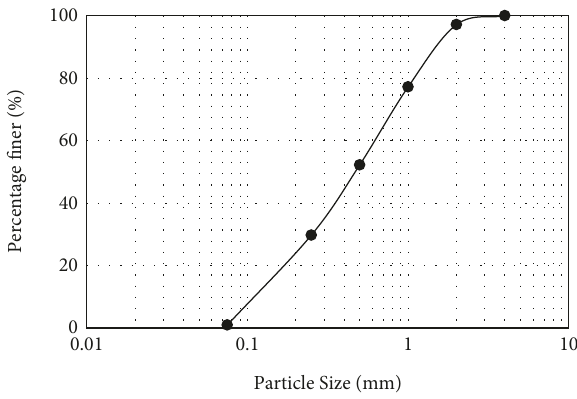
Figure 1: Grain size distribution curve of air-dried